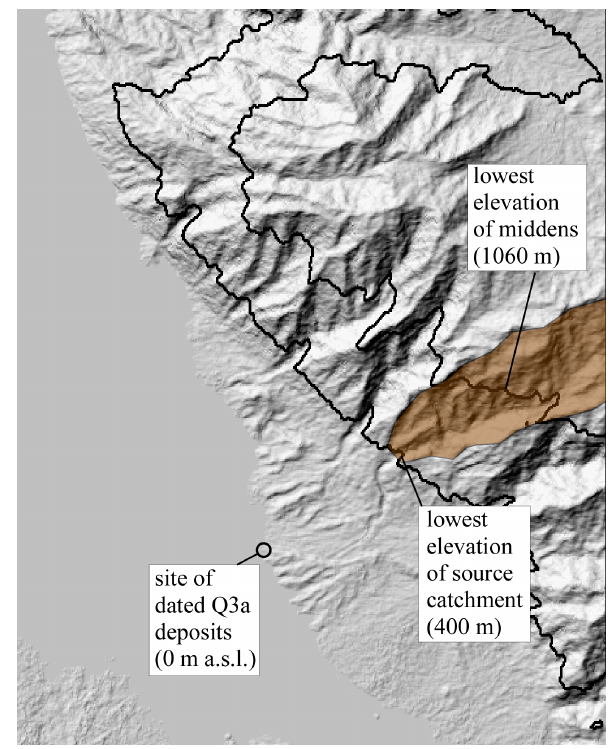
Figure 1. Illustration of the key elevations associated with the southern Death Valley fan-aggradation site, using a shaded-relief image as a base map. Location is shown in Fig. 4. Samples were collected by Sohn et al. (2007) at approximately 0ma.s.l. The tim- ing of the initiation of fan aggradation is controlled, according to the PVCH, by the timing of the retreat of the lower elevational limit of woodland vegetation through the lowest elevations of the source catchment; i.e., 400ma.s.l. In their central Mojave subregion, Anti- nao and McDonald (2013a) used midden records with lowest el- evations of 1060ma.s.l. (Supplement of Antinao and McDonald, 2013a), resulting in an elevational gap of approximately 600m. This gap produces a 6ka cal (calibrated)time lag between assumed and actual paleovegetation changes in the lowest elevations of the source